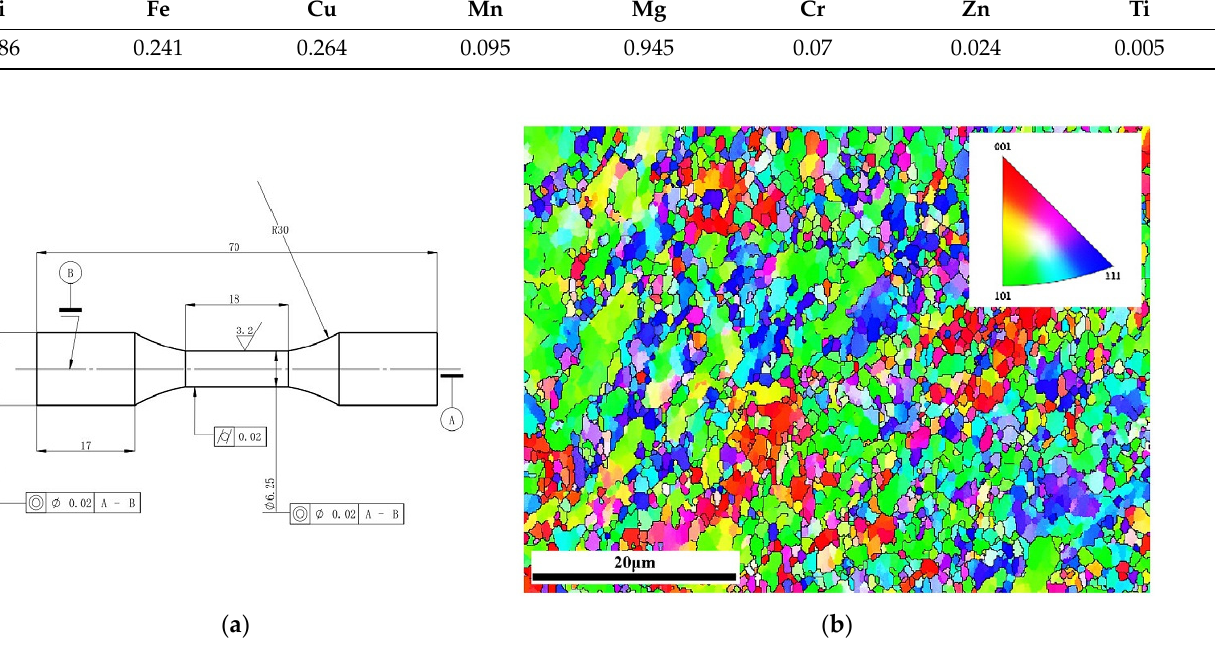
Figure 2. ( a ) Geometric dimensions of the cylindrical specimen (unit: mm); ( b ) EBSD map of UFG AA6061. Table 1. Chemical composition of 6061 aluminum alloy (% in weight).